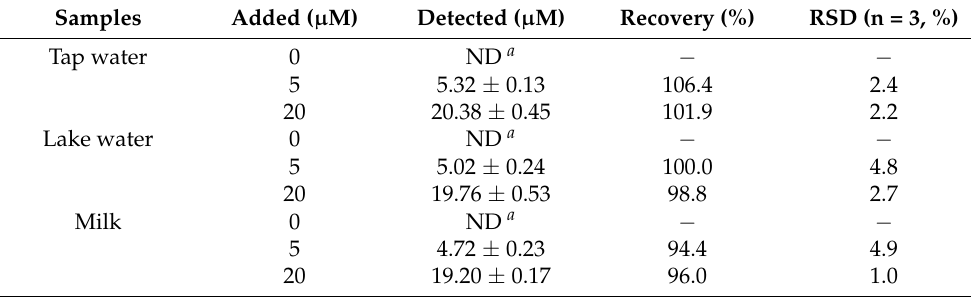
Table 1. Determination of OTC in real